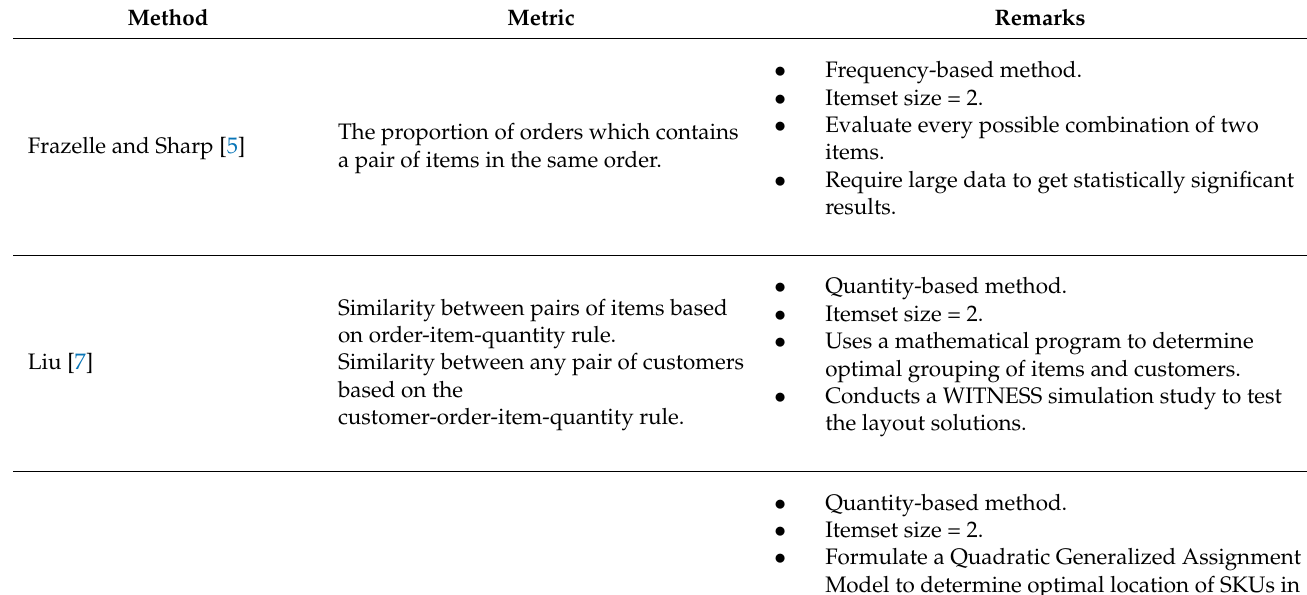
Table 1. Methods for the creating of family